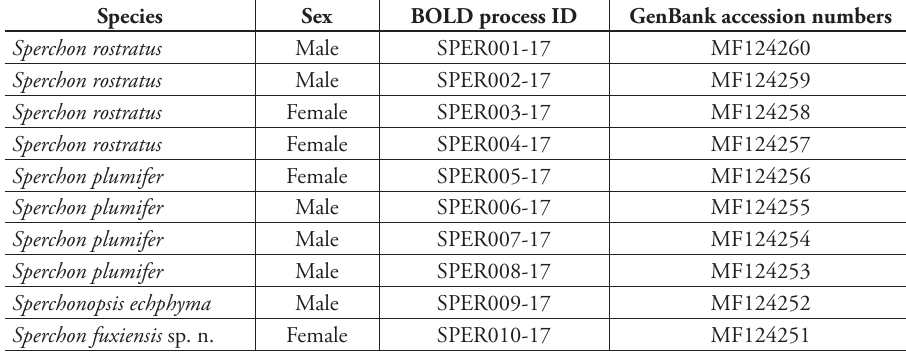
Table 1. Samples examined in this